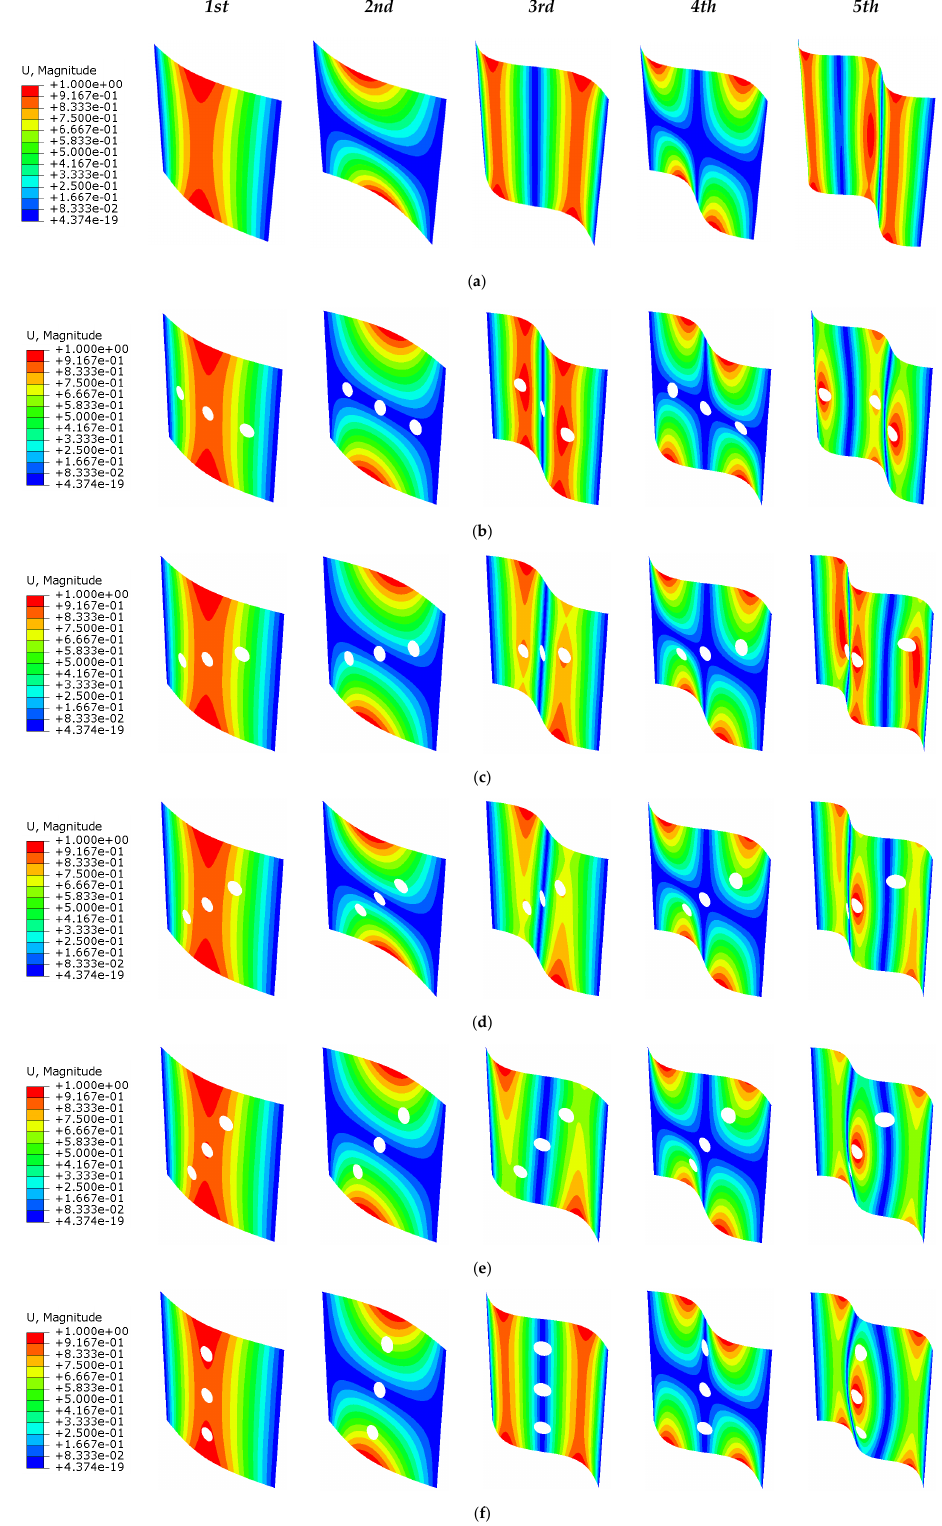
Figure 8. The first five buckling modes of FGM plates with ( a ) a plate thickness of 25 mm, a cutout diameter of 200 mm, and an arrangement of ( b ) 0 ◦ , ( c ) 30 ◦ , ( d ) 45 ◦ , ( e ) 60 ◦ , and ( f ) 90 ◦